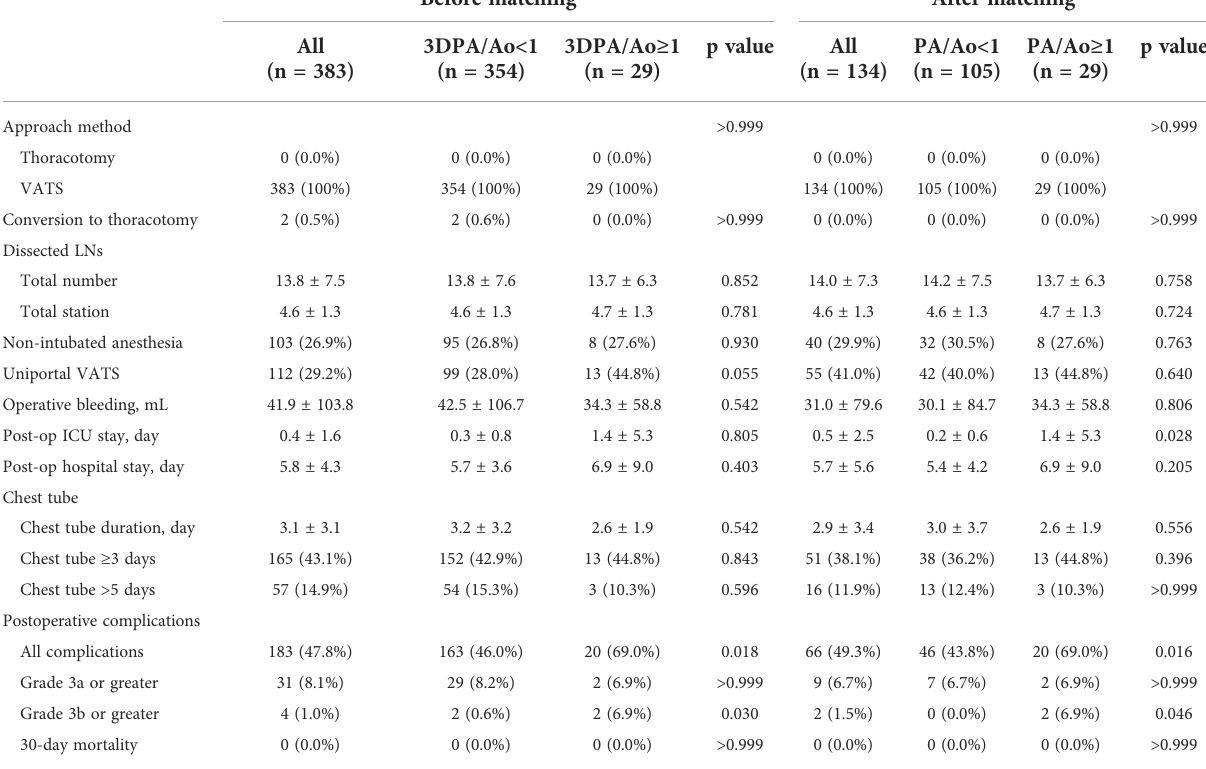
TABLE 3 Perioperative outcomes of lung cancer patients undergoing lobectomy.